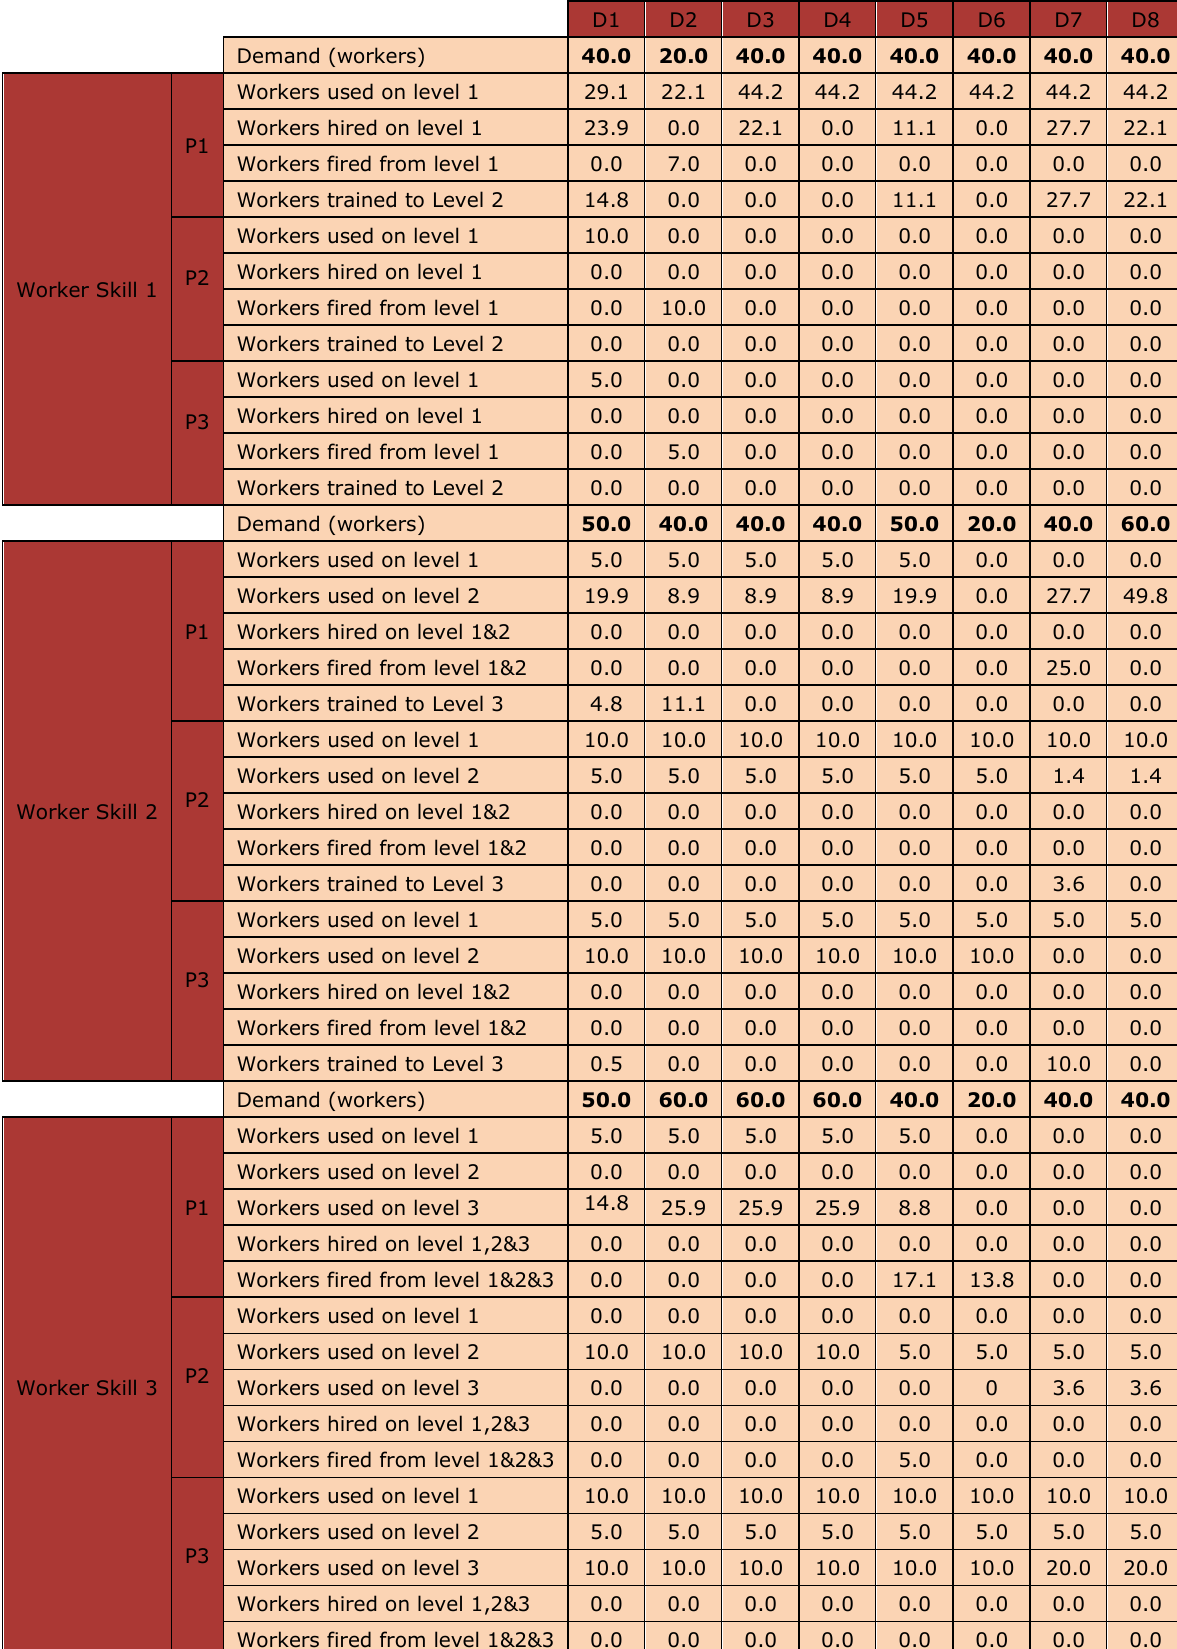
Table 8. Resulting Workforce Plan in Number of